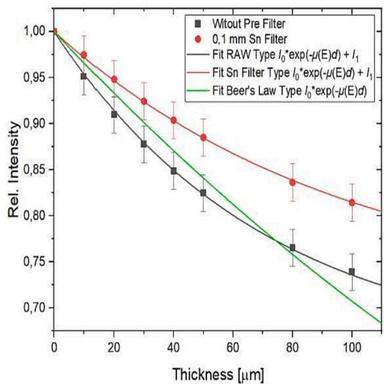
Intensity attenuation measurements on steel foils (CrNi alloy) as a function of thickness with the raw data (black) and the use of a 0.1 mm Sn prefilter (red) with optimized fit functions and origin Beer-Lambert law fit (green) at UA = 140 kV.